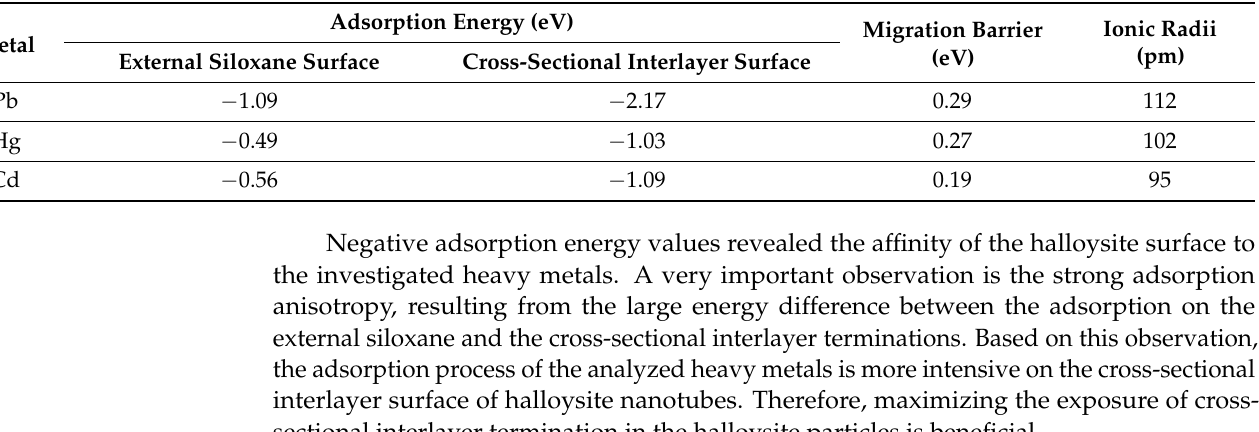
Table 8. Adsorption energy of Pb, Hg, and Cd on the halloysite (7 Å) surface calculated with DFT and the interlayer migration barriers with ionic